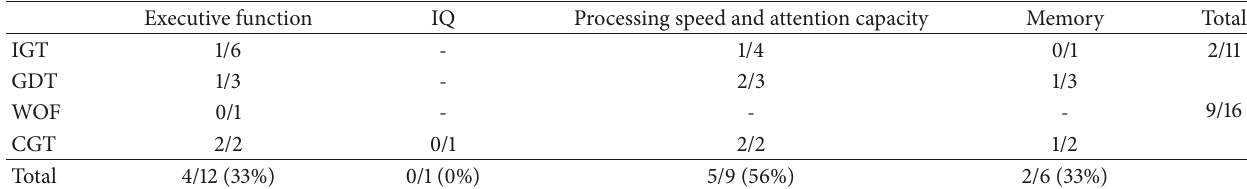
Table 4: Proportion of studies showing a correlation between DM tasks and other cognitive domains. Executive